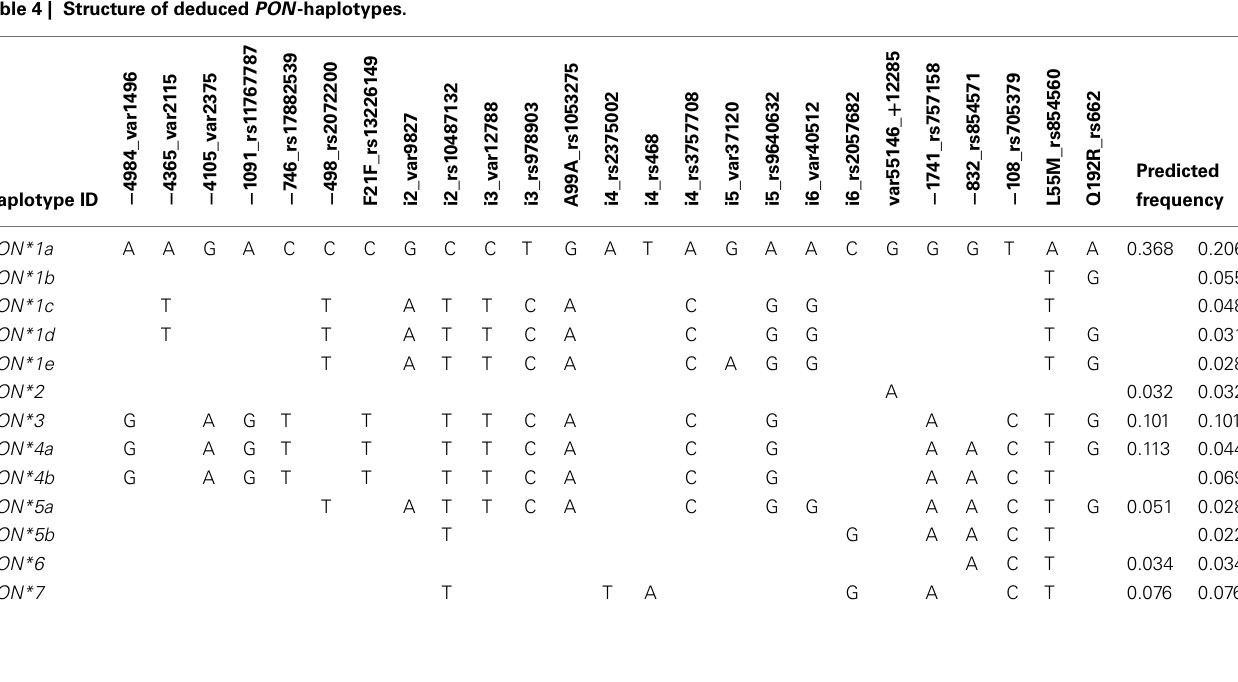
Table 4 | Structure of deduced PON